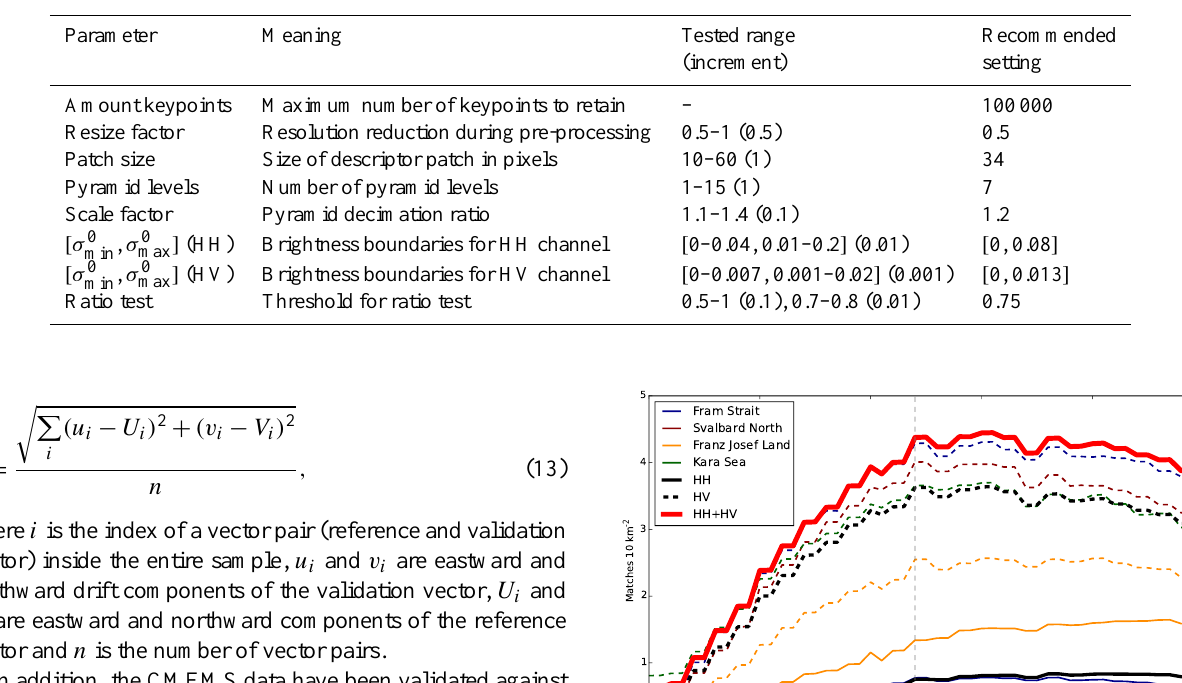
Table 2. Recommended set of parameters for retrieval of sea ice drift from Sentinel-1 data using ORB.